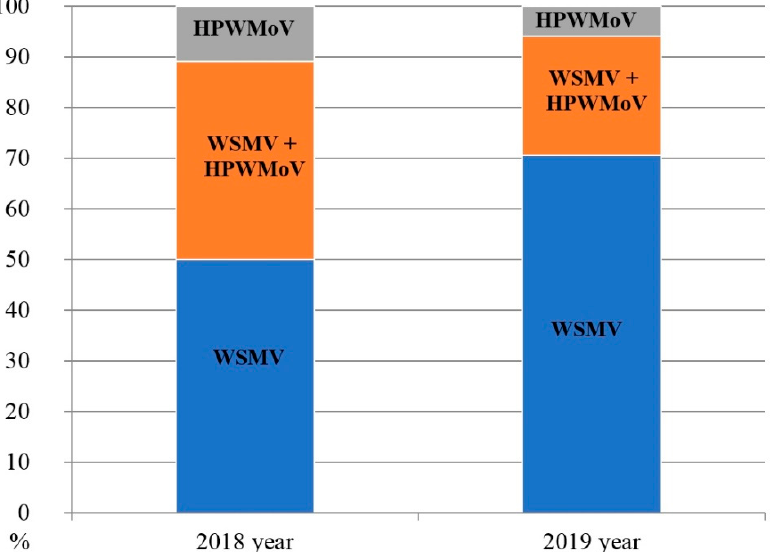
Figure 2. Dynamics of infection patterns induced by wheat streak mosaic virus (WSMV) and High Plains wheat mosaic virus (HPWMoV) in winter wheat in 2018 and 2019.